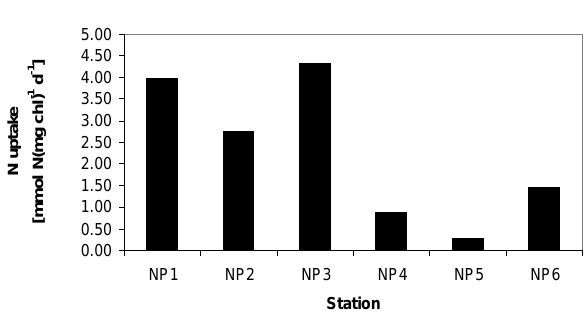
Fig. 10. Euphotic zone (1% for NP1 and NP6, 0.1% for NP2-NP5) integrated chlorophyll- a normalized nitrogen uptake (mmol-at N (mgchl) − 1 d − 1 ) for the six productivity stations of the Southbound Figure 10. Thomalla et al.